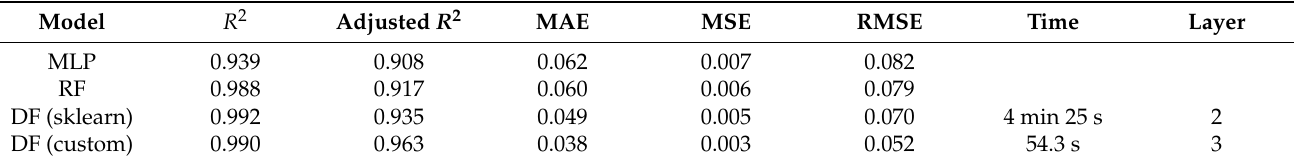
Table 3. Predictive performance of MLP, RF, DF (sklearn) and DF (custom).